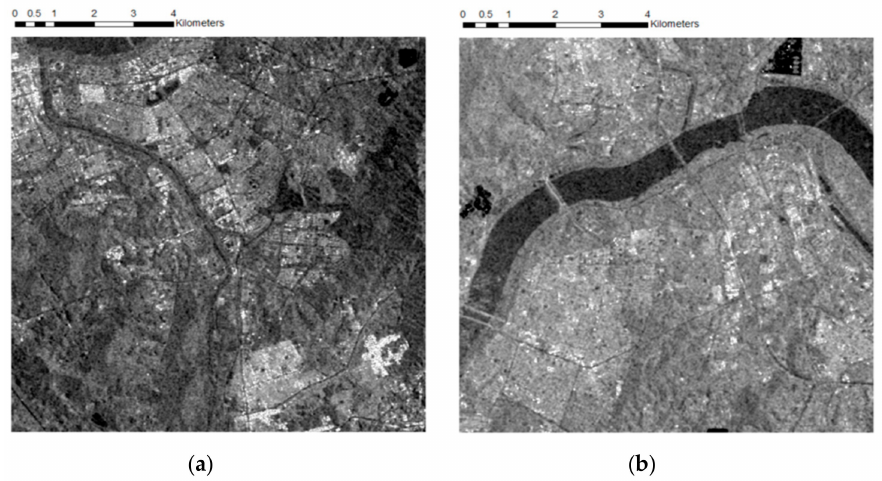
Figure 8. KOMPSAT-5 images with similar time periods as the reference Landsat-8 OLI images (15 July, 2016): ( a ) Site 1, ( b ) Site 2.